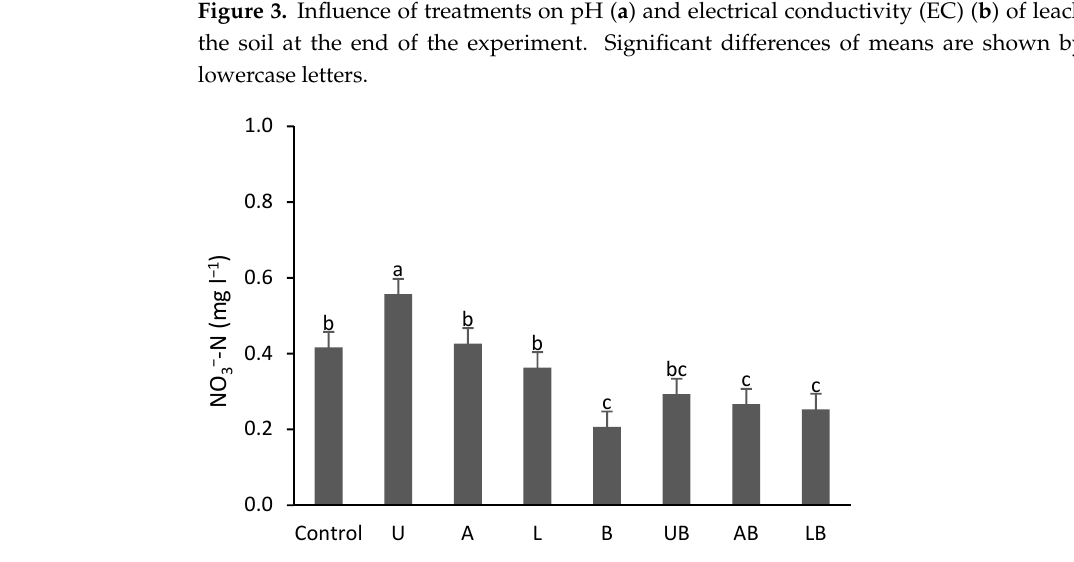
Figure 3. Influence of treatments on pH ( a ) and electrical conductivity (EC) ( b ) of leachates from the soil at the end of the experiment. Significant differences of means are shown by different lowercase letters.